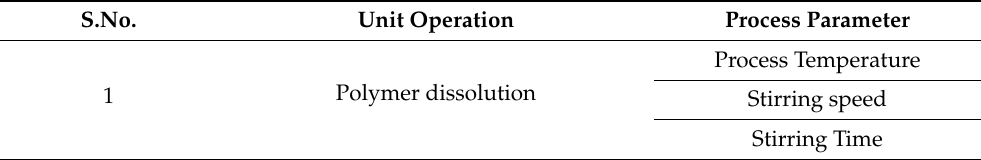
Table 5. Unit operations and the critical process parameters for the preparation of